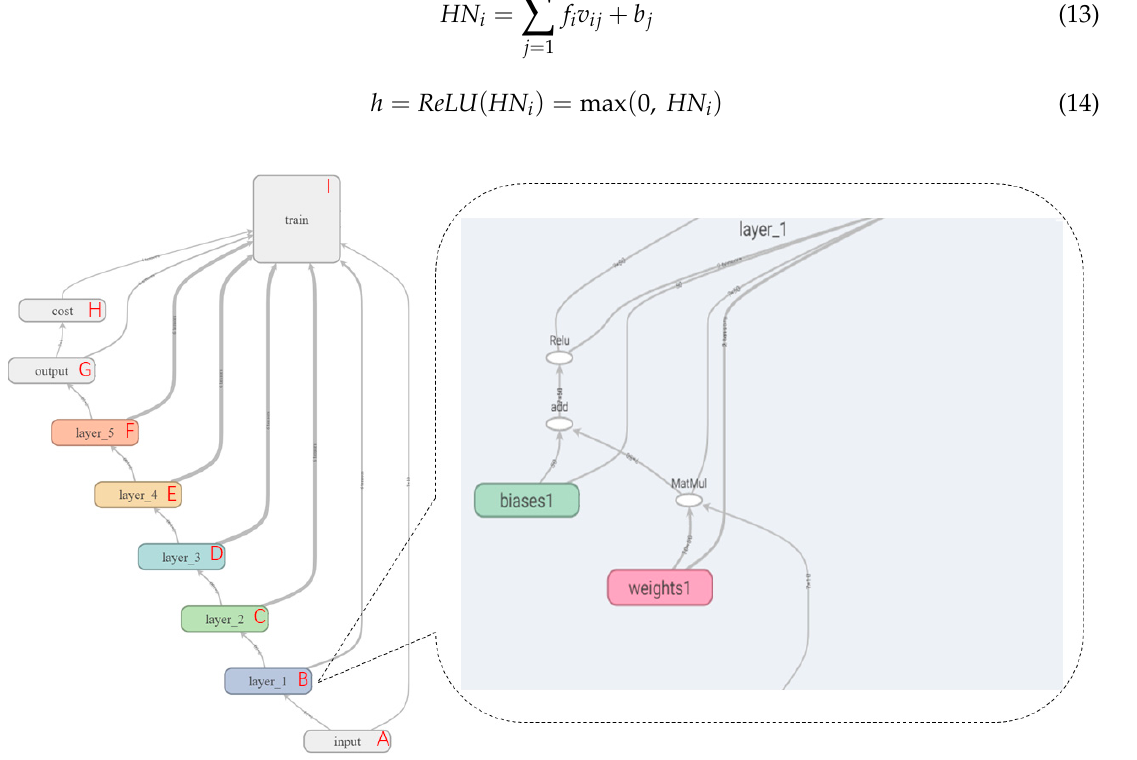
Figure 4. Designed deep learning configuration.